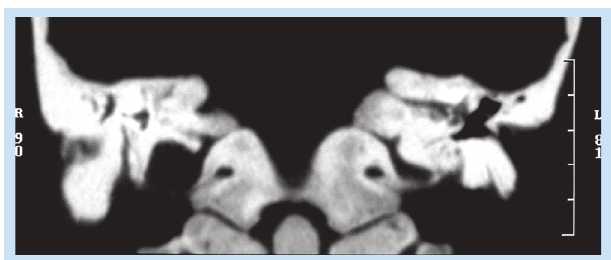
Fig. 2. Temporal bone CT scan showing narrowing in both internal auditory canals and constriction of the contents of both otic